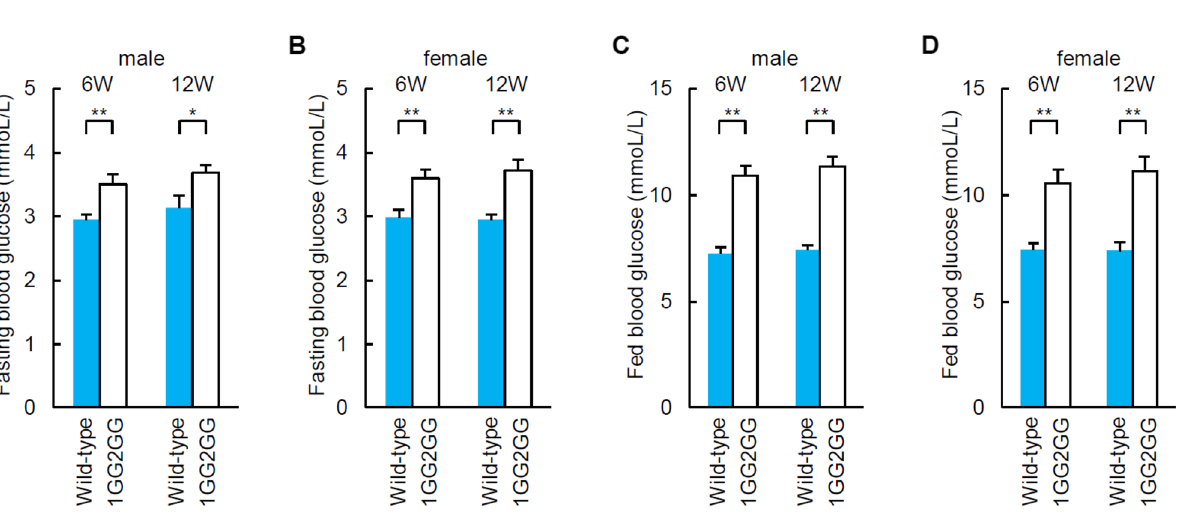
20–30% of insulin transcription in 1GG2GG mice remained, and they were fertile.